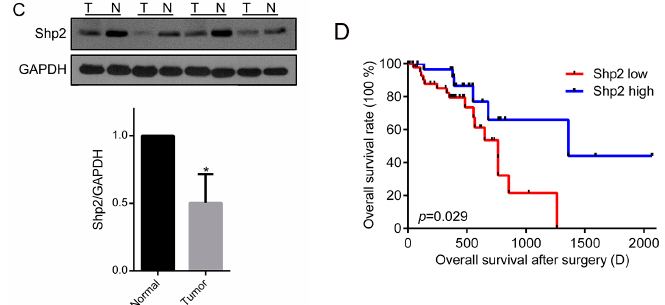
Figure 1. Expression of Src-homology 2 domain-containing phosphatase 2 (Shp2) is reduced in human ESCCs. ( A ) Comparison of Shp2 levels in 67 esophageal squamous cell cancer (ESCC) tissues and adjacent normal tissues using Immunohistochemical (IHC) staining and scoring; ( B ) Representative image of IHC staining of ESCC tissue and adjacent normal tissue; ( C ) Western blot assay of Shp2 expression in ESCC tissues; ( D ) Overall survival was compared between Shp2-high and Shp2-low groups by Kaplan-Meier survival analysis in clinical TCGA ESCC samples. (* p < 0.05, ** p < 0.01).